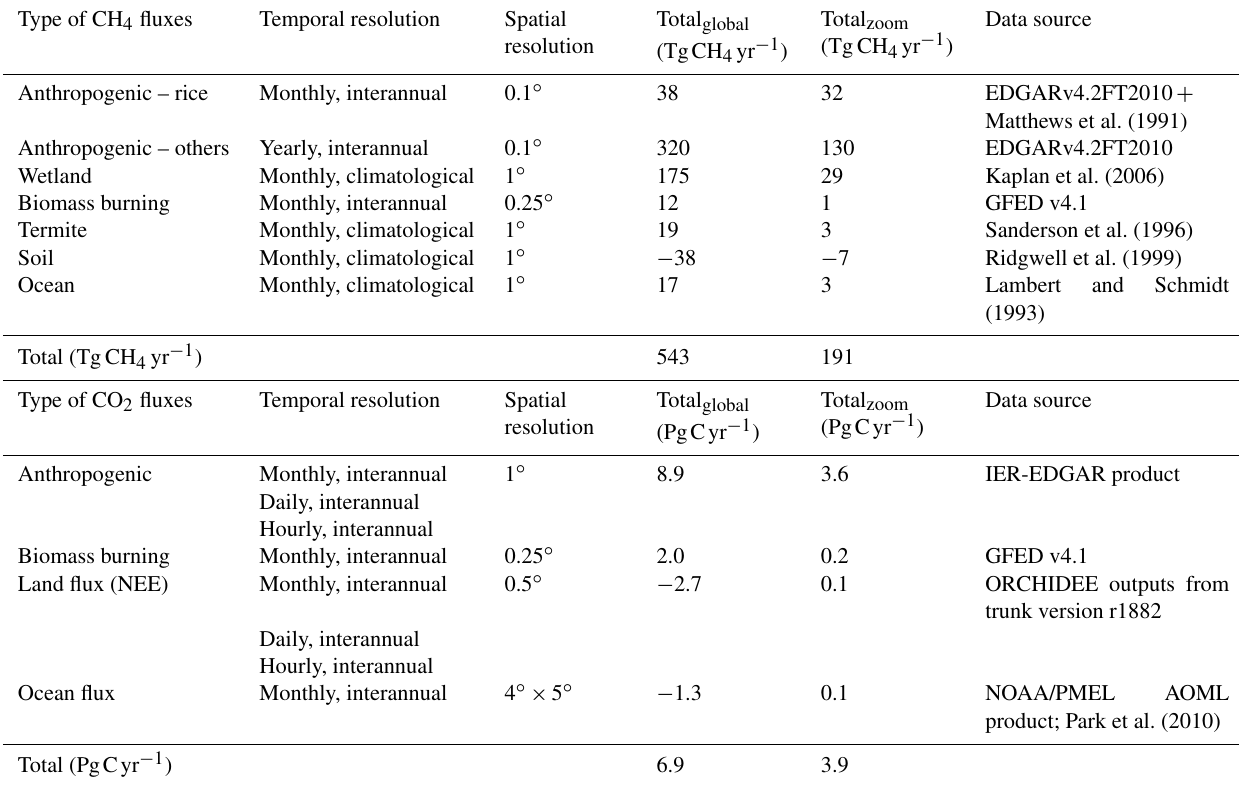
Table 1. The prescribed CH 4 and CO 2 surface fluxes used as model input. For each trace gas, magnitudes of different types of fluxes are given for the year 2010. Total global and Total zoom indicate the total flux summarized over the globe and the zoomed region,